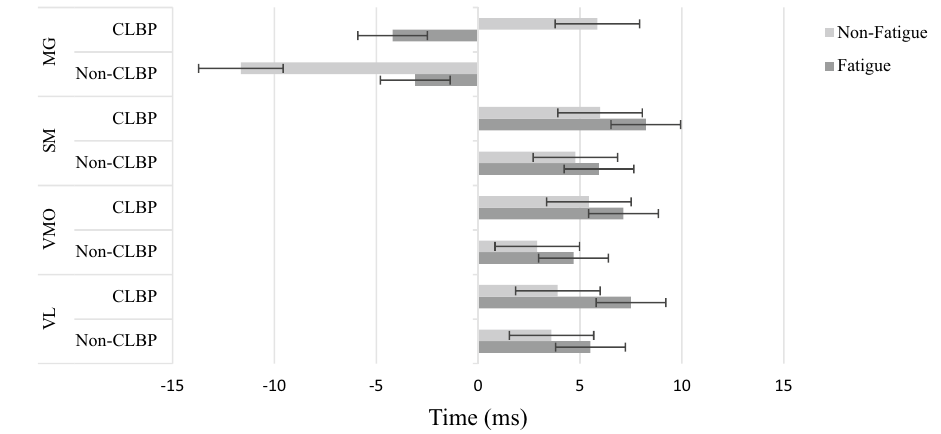
Figure 6. PMT for each muscle by groups (CLBP and Non-CLBP) in non-fatigued and fatigued. VL, Vastus Lateralis; VMO, Vastus Medialis Oblique; SM, Semitendinosus; MG, Med gastrocnemius.